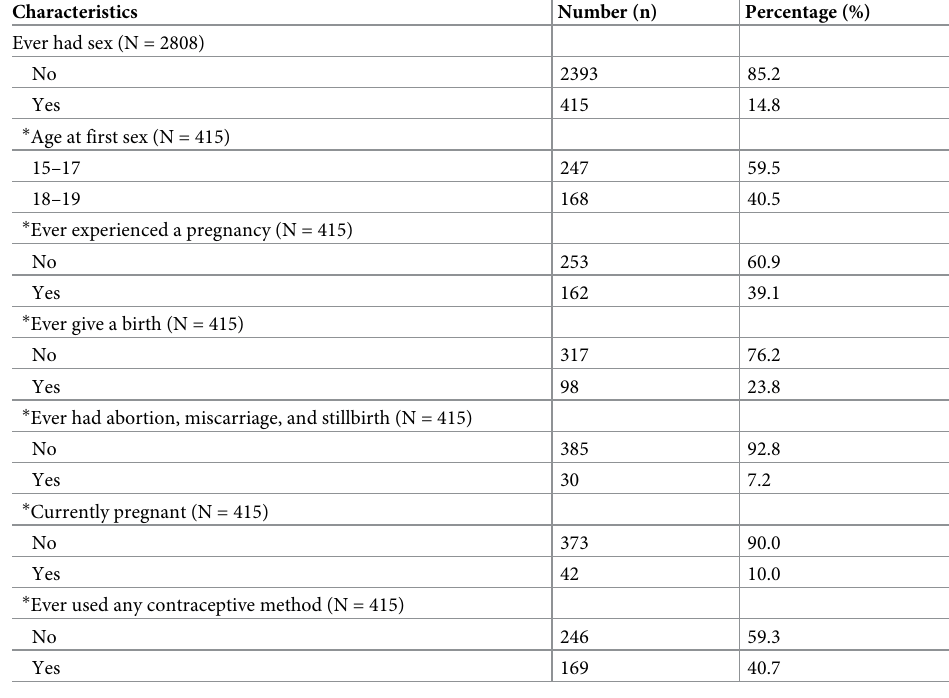
Table 2. Sexual and reproductive health characteristics among adolescent girls aged 15–19 years in Mongolia, SISS 2013 and 2018 (N = 415). Characteristics